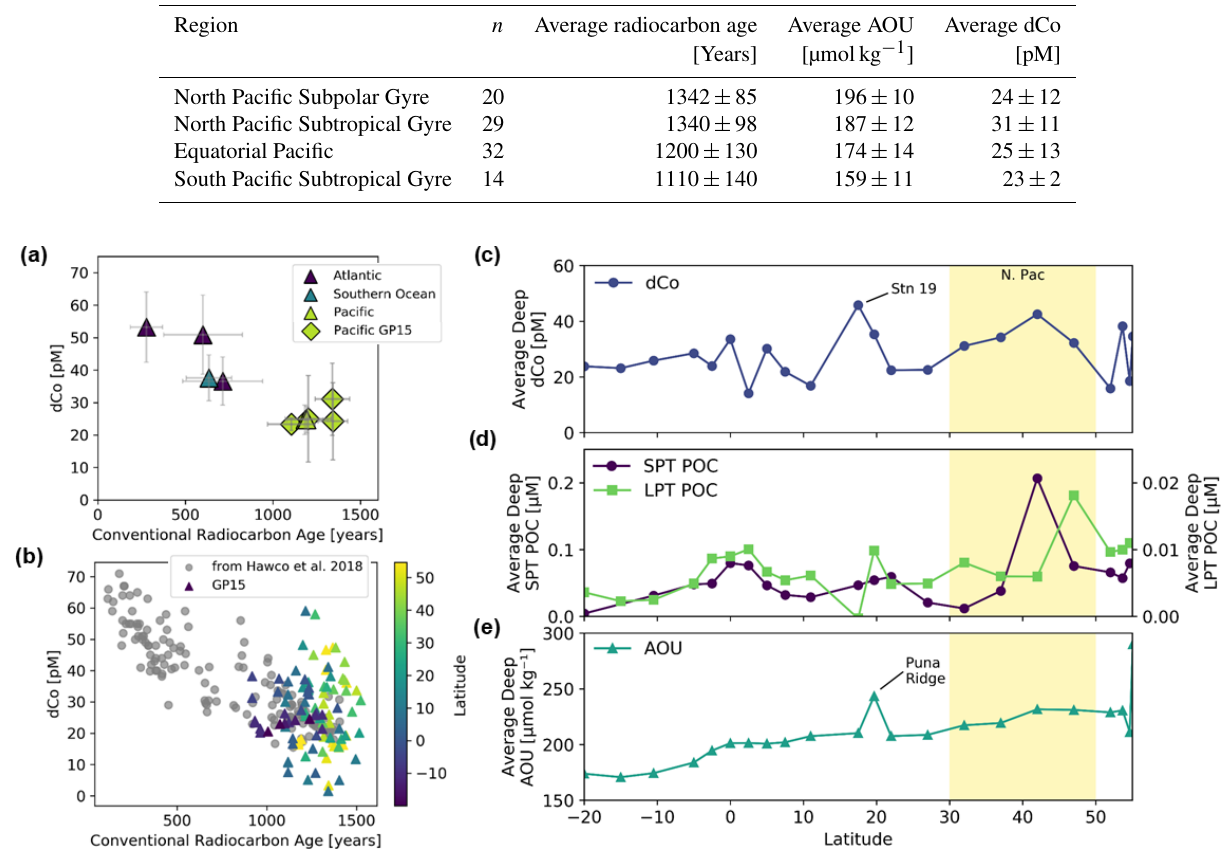
Figure 13. (a) Average dCo concentrations vs. radiocarbon age of the deep ocean ( ≥ 3000m) by oceanographic basin with error bars of standard deviation. Data from GEOTRACES expeditions other than GP15 (triangles) are from Hawco et al. (2018; Table 2 therein); (b) dCo vs. radiocarbon age of individual GEOTRACES dCo samples matched with their nearest GLODAP radiocarbon measurement. (c–e) Deep-ocean ( ≥ 1500m), depth-weighted averages of dCo, small particulate, total (SPT) particulate organic carbon (POC), large particulate, total (LPT) POC and apparent oxygen utilization (AOU) for each deep-station profile. The yellow boxes highlight the region in the North Pacific where average deep dCo and POC are elevated. Note the order-of-magnitude difference between the scales of the POC y axes (d)